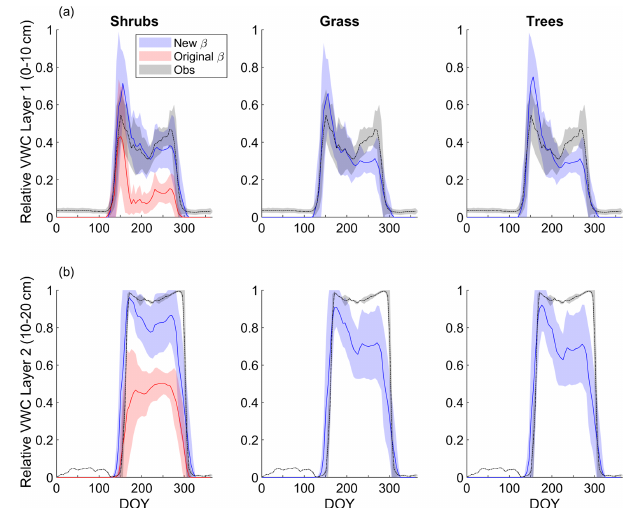
Figure 3. Mean 5d average simulated relative volumetric water content (VWC, m 3 m − 3 ; see Eq. 11) (a) for the top model soil layer (0–10cm depth) and observations at 7cm depth and (b) for the sec- ond layer (10–20cm depth) and observations measured at 20cm depth averaged over 2004–2017 for the shrub, grass, and tree sim- ulations. For the shrub simulation, results using the new (Merlin et al., 2011) and original β (Lee and Pielke, 1992) formulation are shown. Measurements at the 20cm depth were only available start- ing late August 2015, while measurements at the 7cm depth began in June 2004. Shaded areas show the standard deviation for 2004– 2017 for the model results and observations at 7cm depth and for 2015–2017 for observations at 20cm